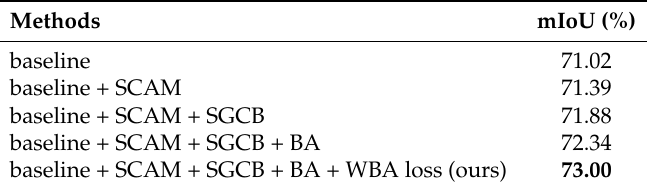
Table 4. Ablation experiments of EHANet on CelebAMask-HQ validation set. “SCAM” denotes stage contextual attention mechanism module, “SGCB” denotes semantic gap compensation block, “BA” denotes boundary-aware branch, “WBA loss” denotes weighted boundary-aware